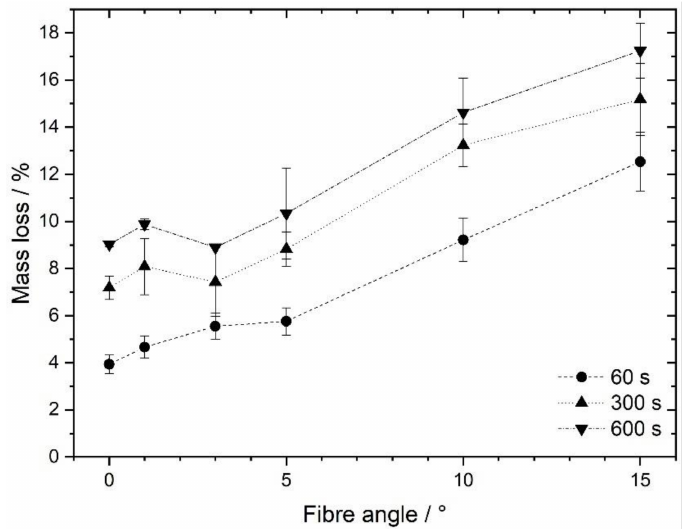
Figure 10. Mass loss of CFRP with an out-of-plane fibre orientation after different durations of hot-air